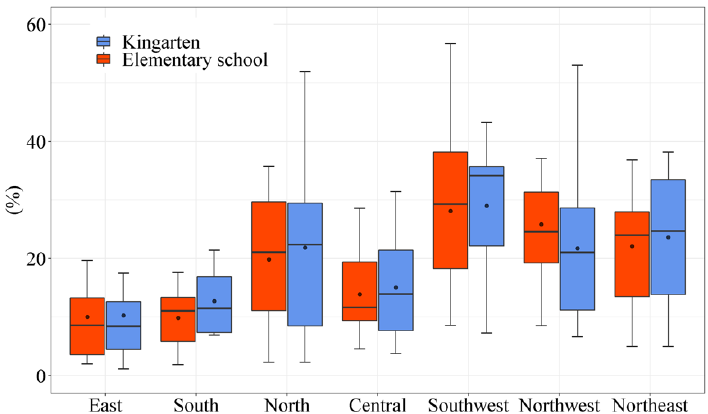
Figure 9. The percentage of administrative villages without elementary schools or kindergartens within more than 30 min travel time in the seven regions (Source: by the authors).